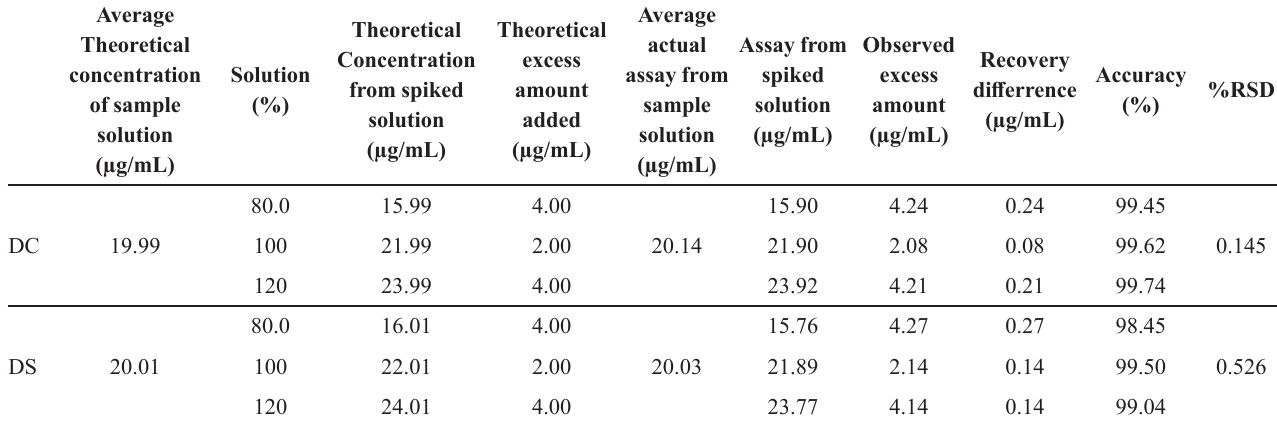
TABLEII - Table for accuracy study DC and DS for ratio derivative spectroscopy analysis Average Theoretical concentration of sample